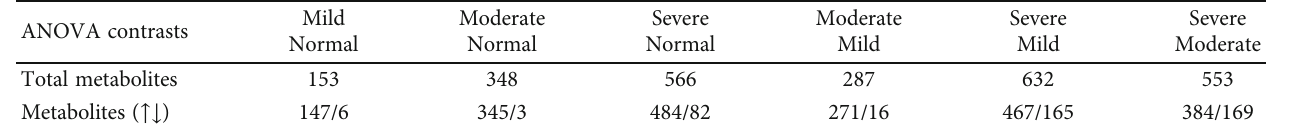
Table 2: The numbers of signi fi cantly changed metabolites among di ff erent